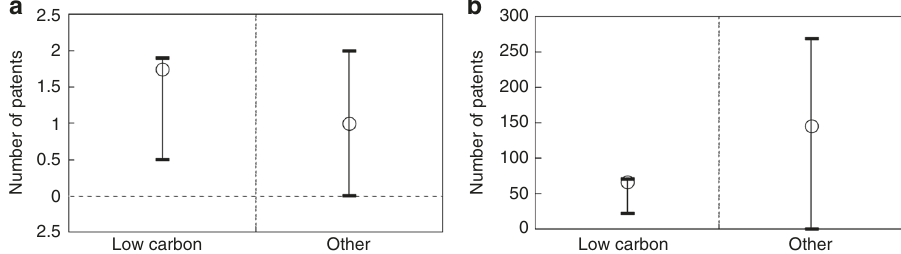
Fig. 3 Rate and direction of ETS-induced innovation. a Firm-level effects and b aggregate effects on the number of low-carbon and other technology patenting and 95% con fi dence intervals. The aggregate effect was calculated by applying the individual effect to fi rms with consideration of the corner solution at zero